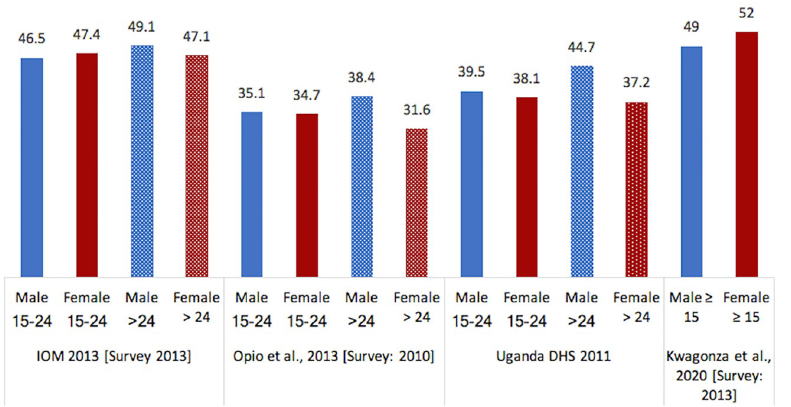
Fig 3. Comprehensive knowledge of HIV/AIDS. DHS: Demographic Health Survey. The numbers represent the prevalence reported as percentage (%).